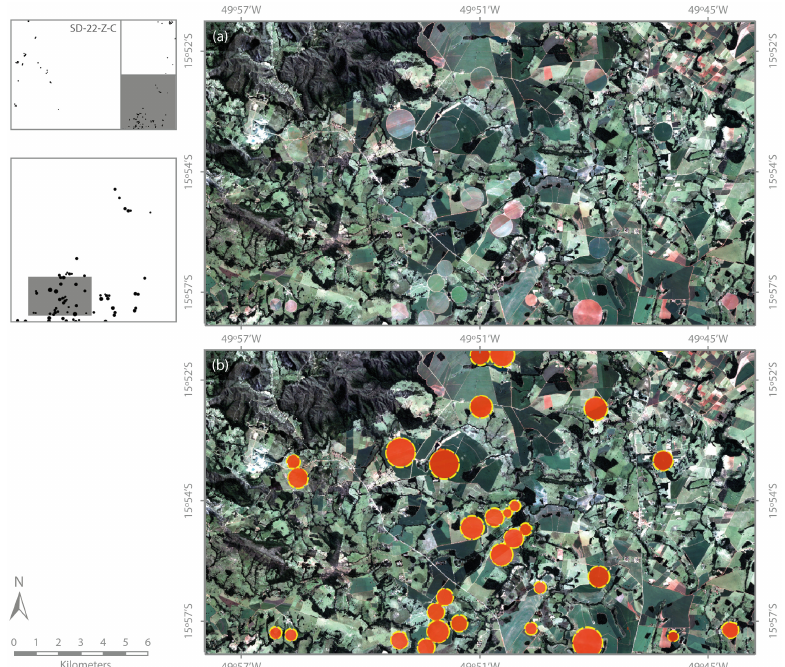
Figure 7. Results for an area of grid SD-22-Z-C-5 in the Brazilian Continuous Cartographic Base, located in the municipalities of Goiás and Itaberaí, in the state of Goiás. ( a ) PlanetScope median mosaic, in true color composition, built using images from the period from August 2017 to November 2018; ( b ) comparison between the reference (yellow dotted lines) and our results (red).